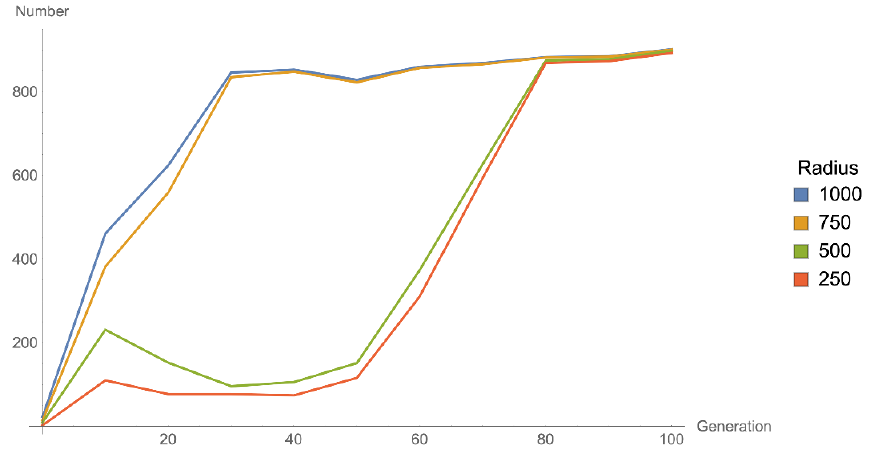
Figure 2 . Number of individuals within di(cid:11)erent ranges around W (cid:3)